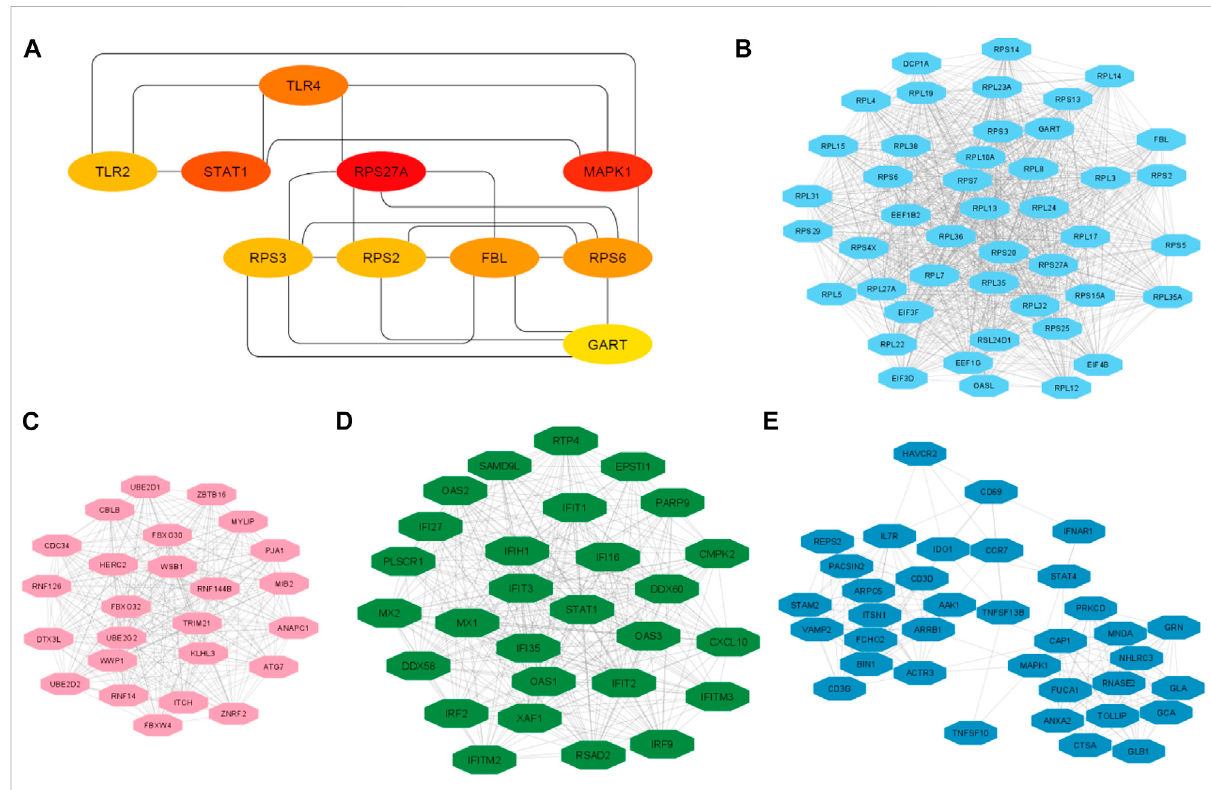
FIGURE 5 The top ten hub genes and top 4 clusters. (A) Identify the top 10 hub genes and their interaction. (B) Interaction of nodes in cluster 2. (C) Interaction of nodes in cluster 3. (D) Interaction of nodes in cluster 3. (E) Interaction of nodes in cluster 4.